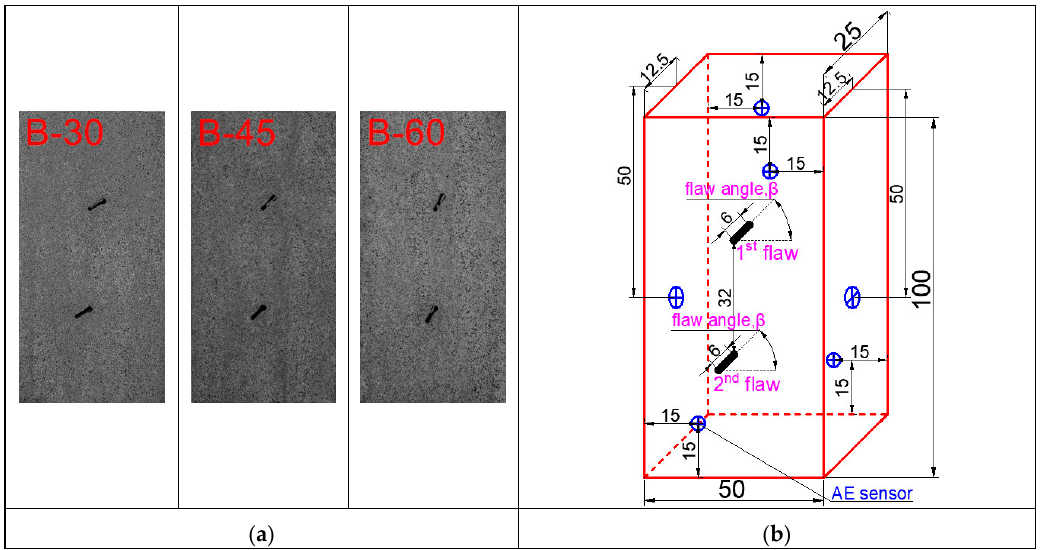
Figure 2. Diagram of selected samples: ( a ) material objects; ( b ) detailed geometries (distance unit: mm).